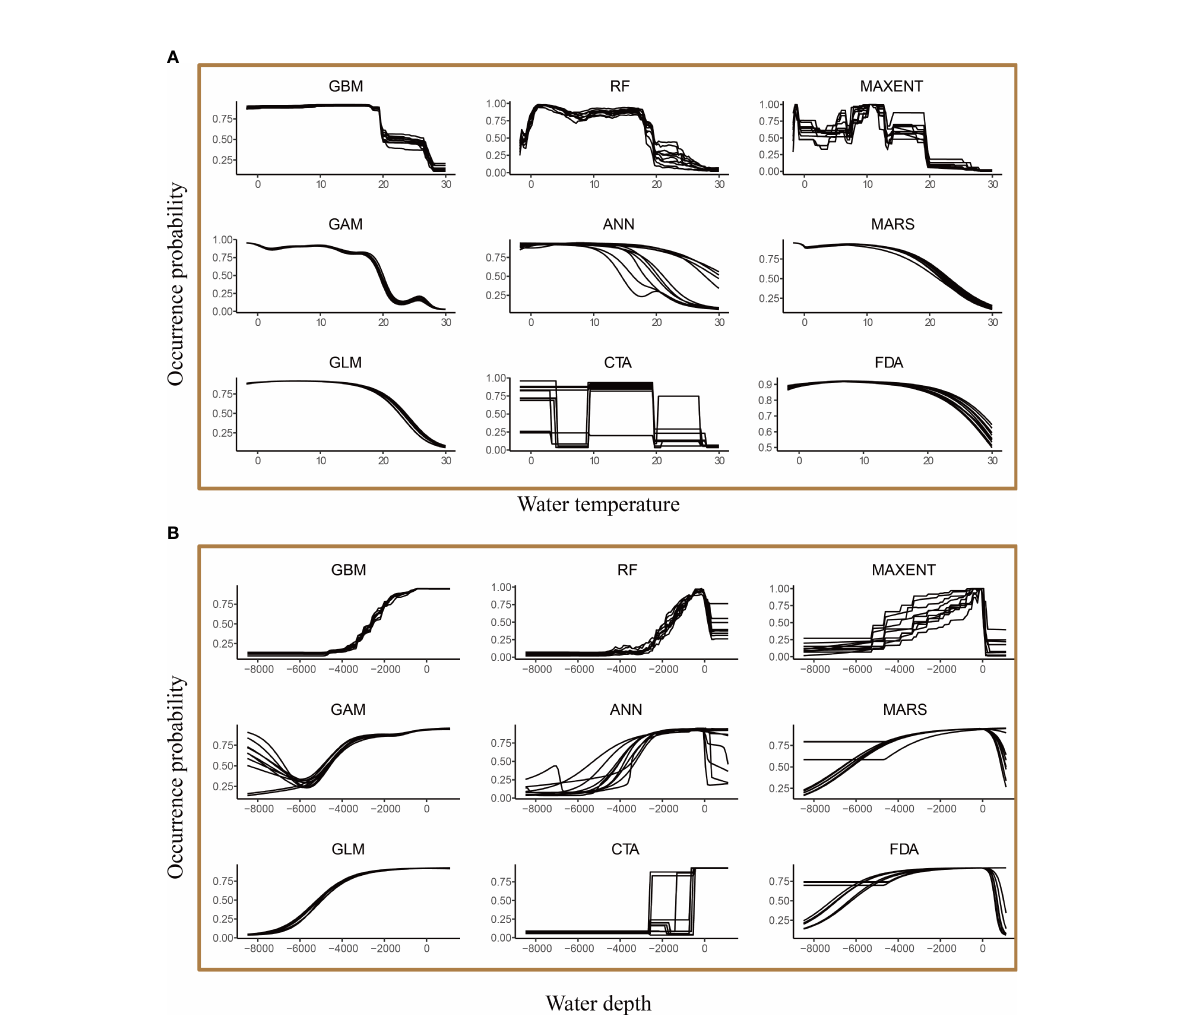
FIGURE 5 The response curves of the common minke whale occurrence probability against water temperature (A) and water depth (B) based on the species-level